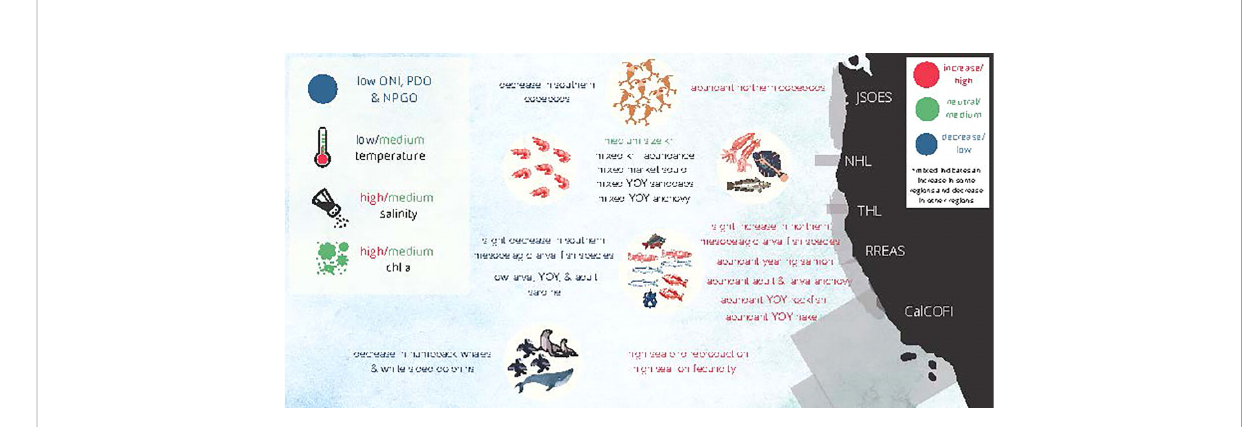
FIGURE 10 Graphical summary of CCE conditions in